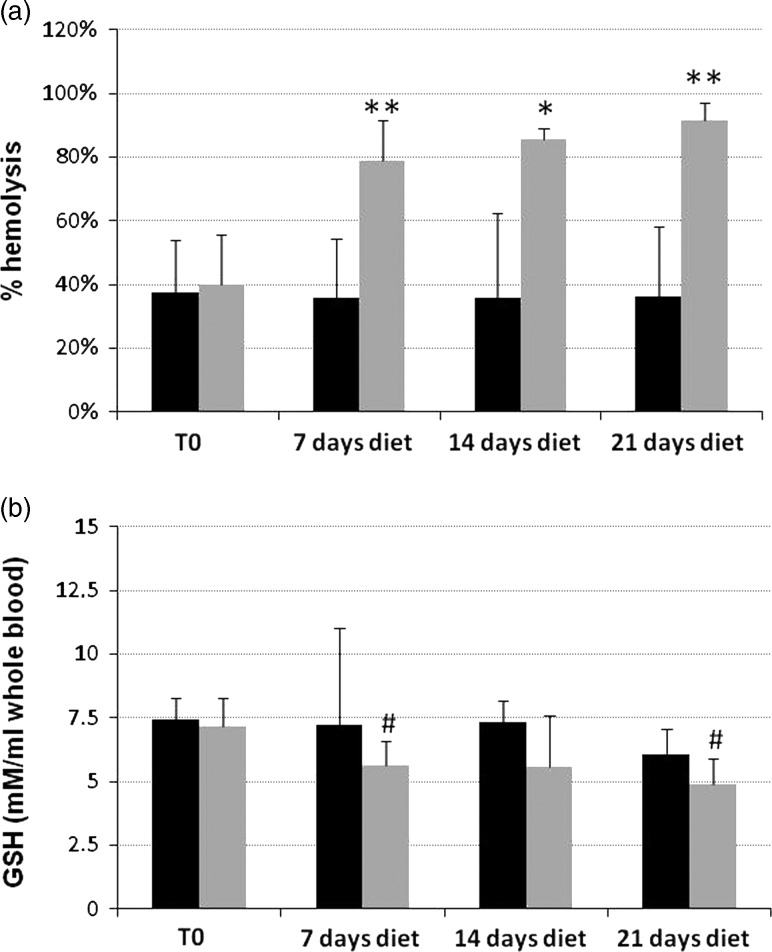
Screening assay for red blood cells (RBC) redox sensitivity (a) and measurement of Glutathione (GSH) levels in RBCs (b) from hens in Trial 2. (a) Hen RBCs were incubated on a microplate shaker (1000 r.p.m.) for 12 h in the dark at room temperature, in the presence of 2 mM H2O2 after 3 weeks of control soybean diet (black bars) or a diet supplemented with 25% high vicine (V)+convicine (C) faba beans (light gray bars) (check points on days 0, 7, 14 and 21). Column data represent mean values±SD of four independent experiments analyzed for statistical significance by two-sided Student’s t-test. Percentage of hemolysis in RBCs from hens fed the high V+C diet was significantly higher than control RBCs (all **P<0.003, but *P<0.01 for day 14), and then at time 0 for the control diet and time 0 for the faba bean diet (P<0.001). (b) GSH levels (expressed as mmoles/ml whole blood) were measured in hen RBCs after 3 weeks of control soybean diet (black bars) and a diet supplemented with 25% high V+C faba beans (light gray bars) (check points on days 0, 7, 14 and 21). Column data represent mean values±SD of four independent experiments, analyzed for statistical significance by two-sided Student’s t-test. The differences between days 7 and 21 v. day 0 were statistically significant (#
P<0.05).